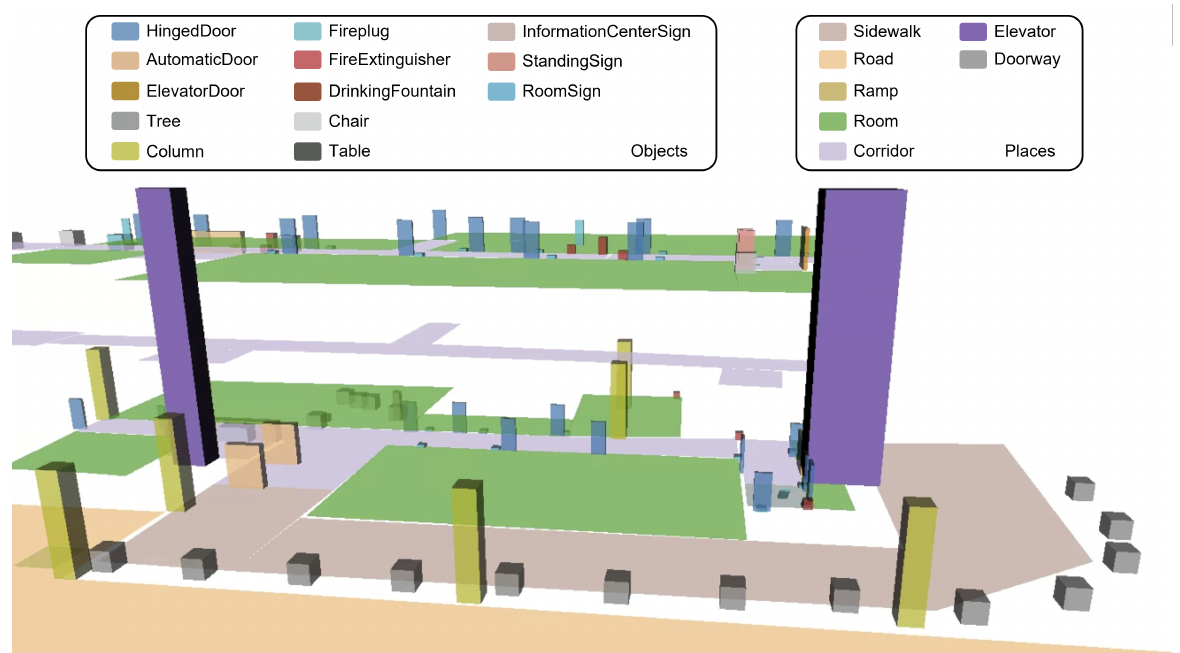
Figure 3. The explicit model-based visualization of objects and places on the generated semantic map.